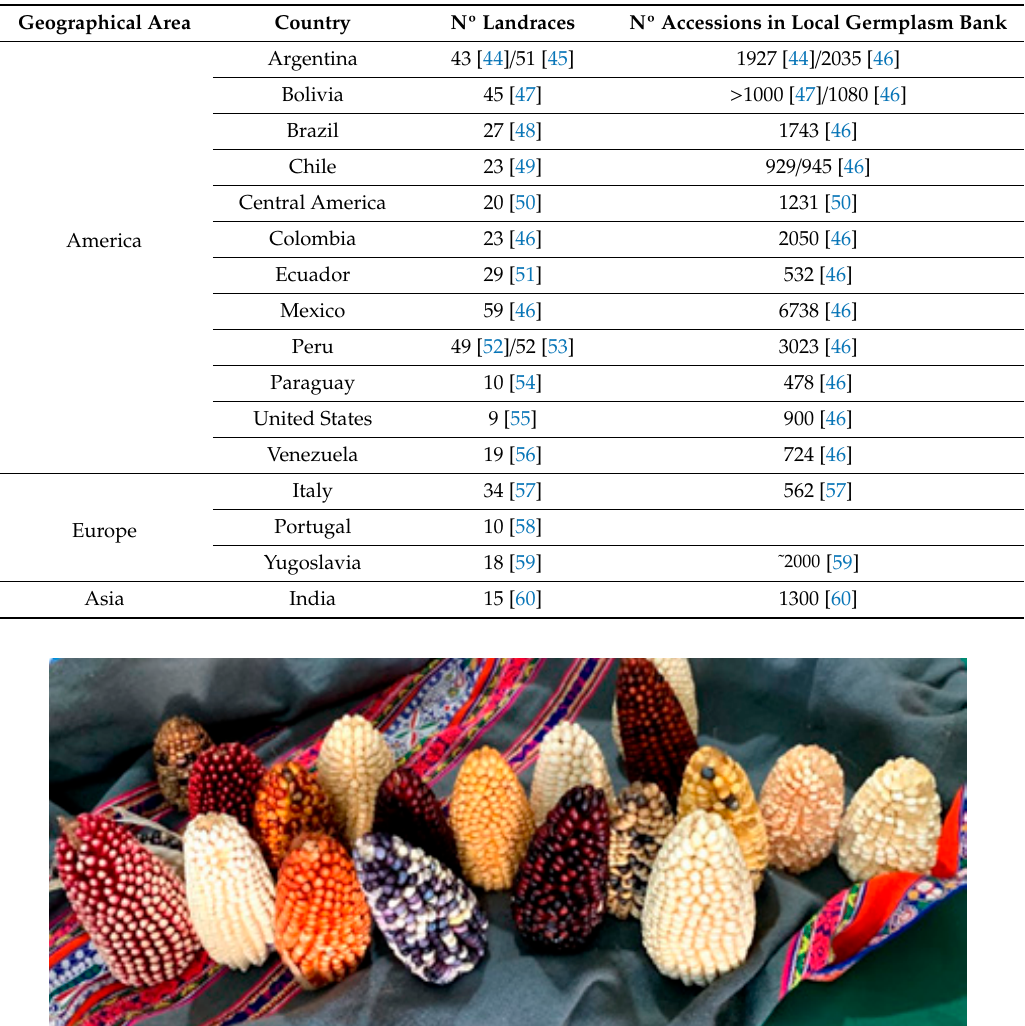
Table 1. Number of native corn landraces per country (ex situ conservation).